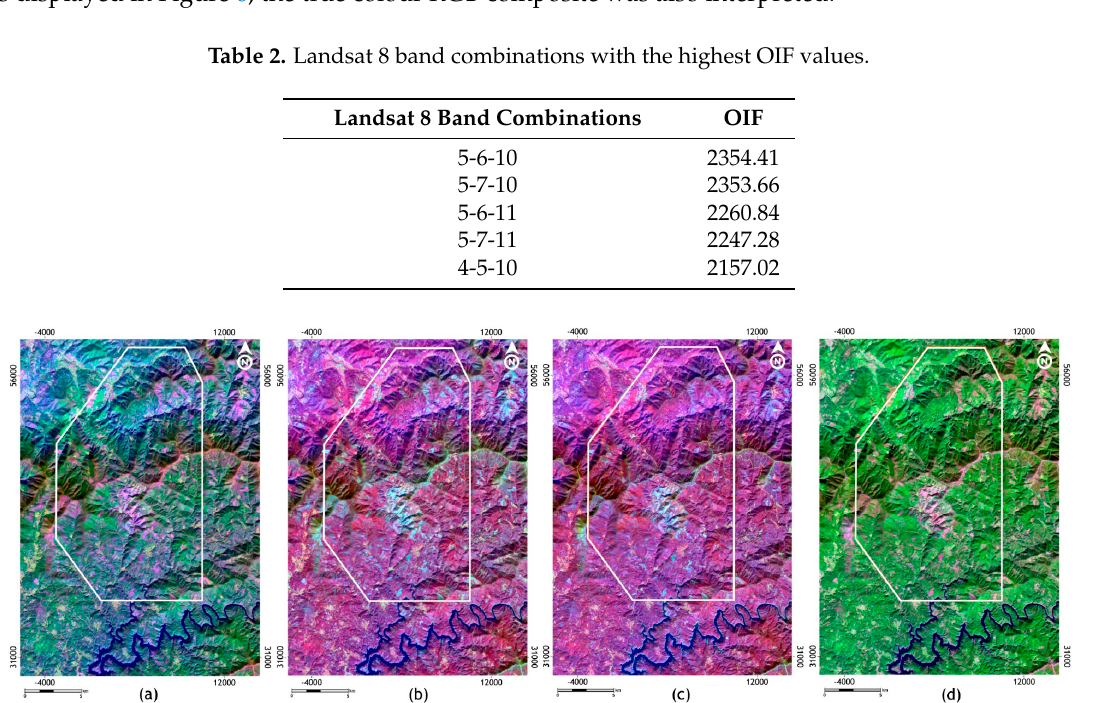
Figure 5. RGB colour composites used for geological interpretation: ( a ) 6-5-10; ( b ) 5-7-11; ( c ) 5-8-10 and ( d ) 7-5-2.